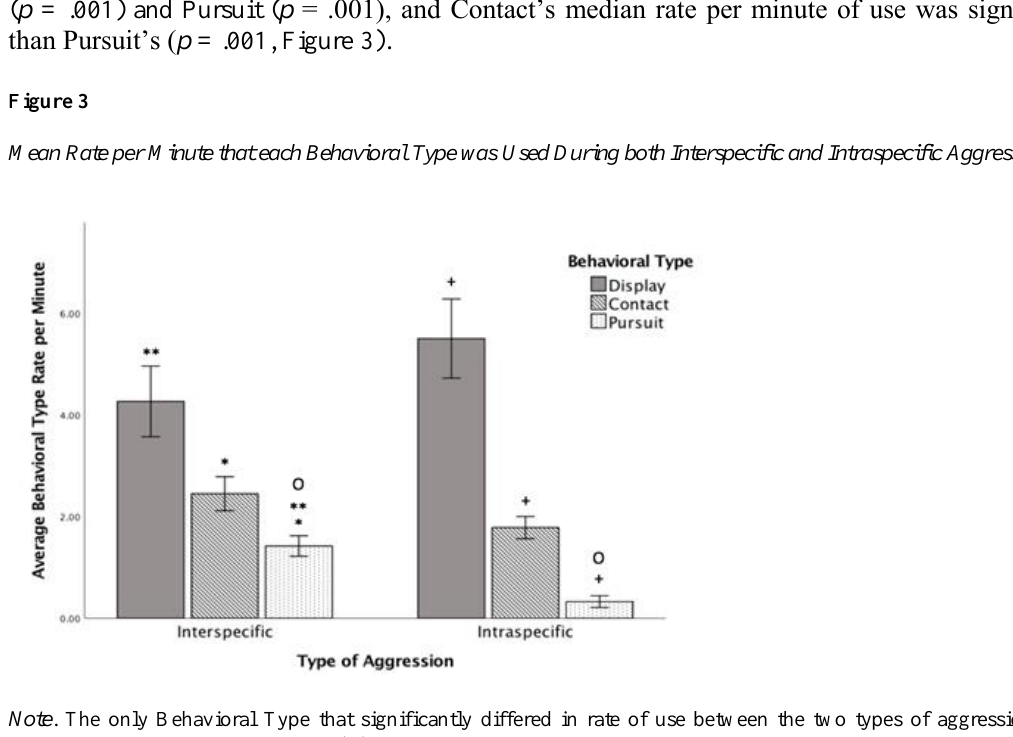
Note . The only Behavioral Type that significantly differed in rate of use between the two types of aggression was the Pursuit Behavioral Type, designated by the (O). The Pursuit Behavioral Type was used significantly more during interspecific aggression than intraspecific aggression. This graph also shows that during interspecific aggression, both the Display and Contact Behavioral Types were used significantly more than the Pursuit, designated by the (*) for the significant difference between Pursuit and Contact, and designated by the (**) for the significant difference between Pursuit and Display. For intraspecific aggression, all three Types differed significantly from each other, designated by the (+). Error bars indicate +/- SE